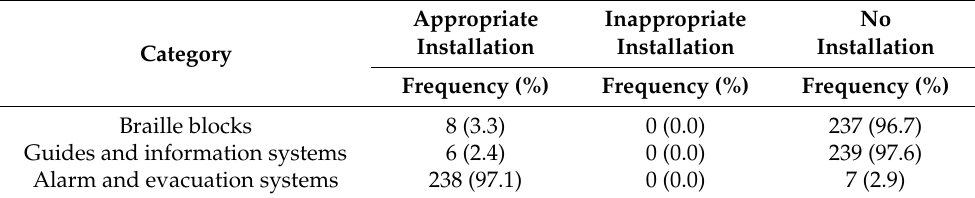
Table 6. Installation condition of the information facilities.